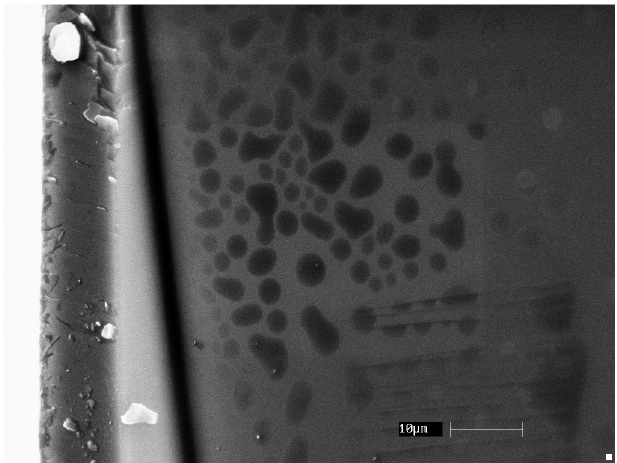
FIG. 15. A lower resolution, larger scan range SEM micro- graph beneath the damage site. The surface of the substrate is towards the right.